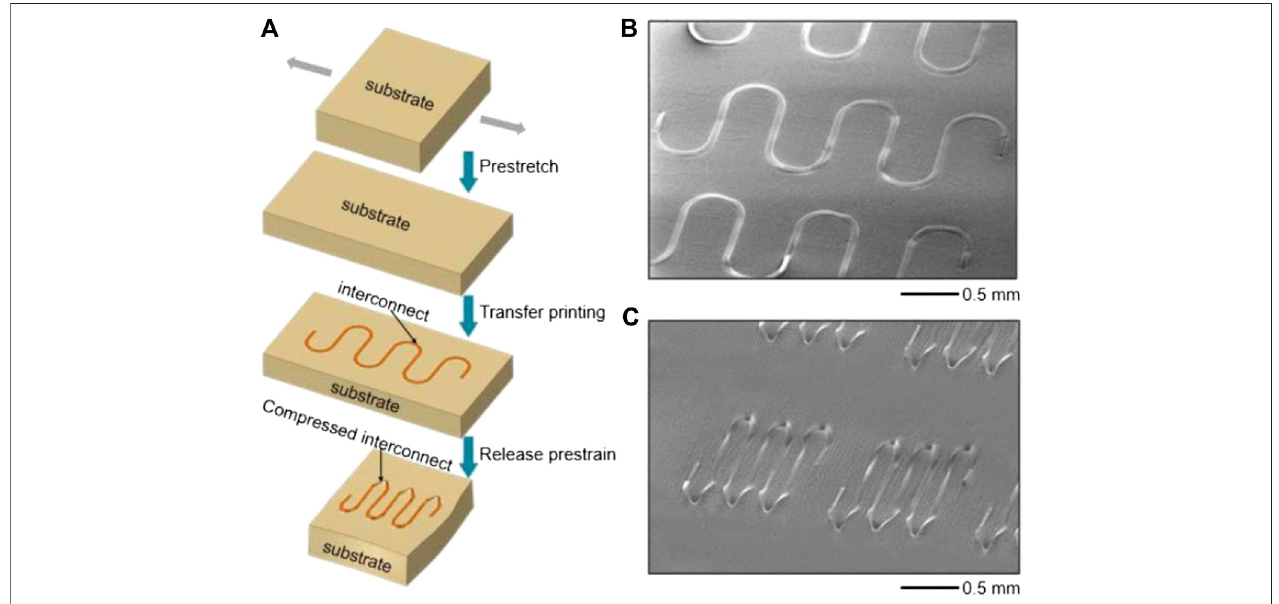
FIGURE 9 | (A) Schematic illustration of the prestrain strategy for fabricating serpentine interconnects with enhanced levels of stretchability. (B) SEM image of the serpentine structures before releasing the prestrain of the substrate. (C) SEM image of the serpentine interconnect after releasing the prestrain of the substrate (Zhang et al., 2014). Reproduced with